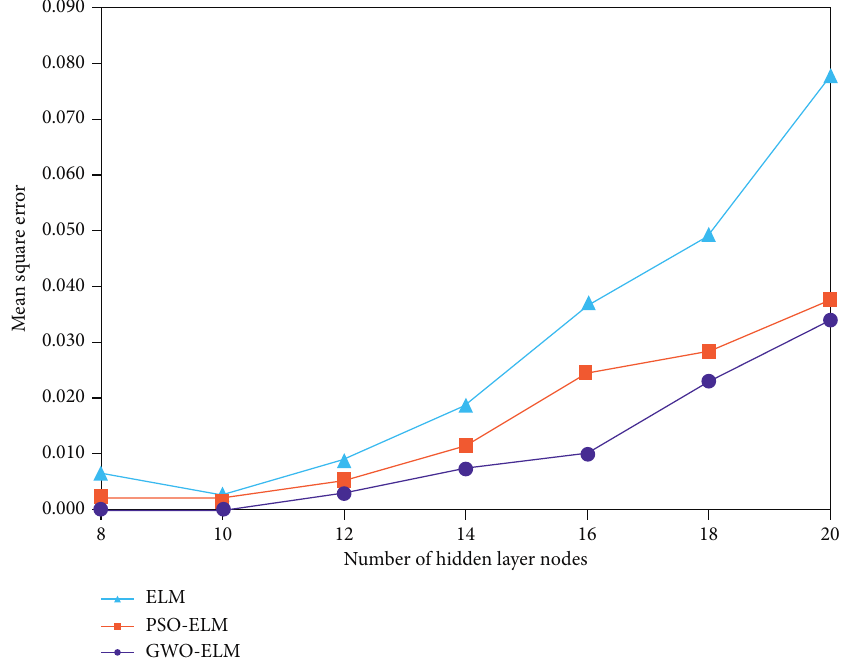
Figure 4: The relationship between the mean square error value of the prediction sample and the